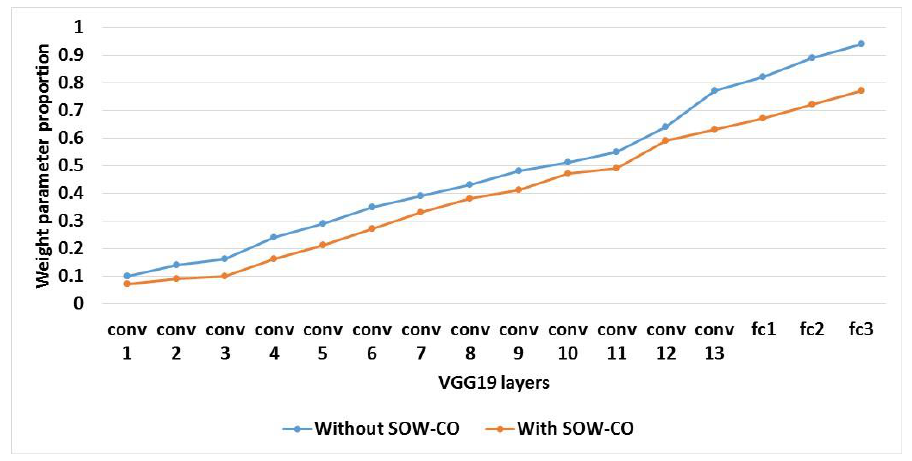
Figure 20. Graphical illustration of weight parameter proportion for VGG19.